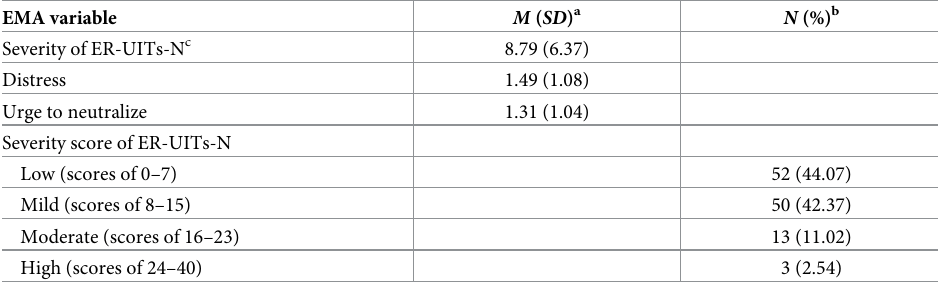
Table 2. Means and standard deviations of severity of ER-UITs-N, distress, and urge to neutralize, and number of occurrences of low, mild, moderate, and high scores of the severity of ER-UITs-N during the EMA period.